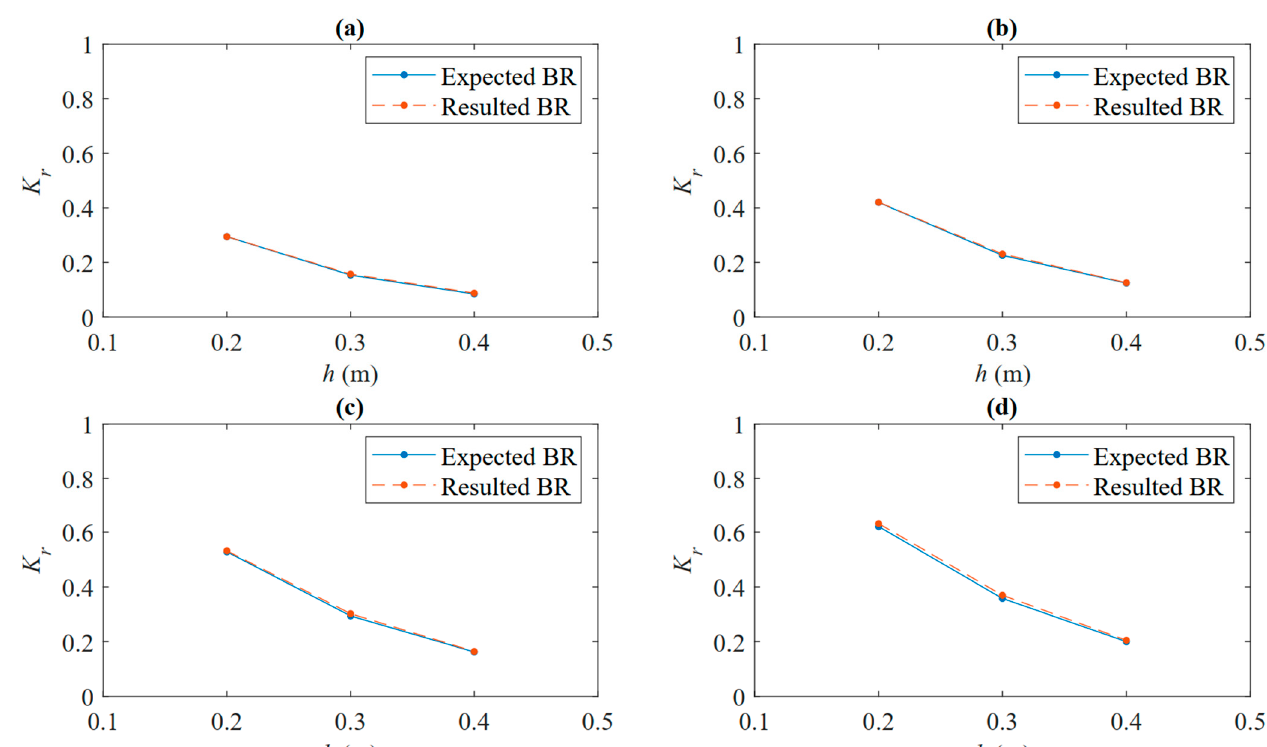
Figure 17. Bragg resonance of multiple periodically submerged breakwaters with 1.0 m structural wavelength S at different water depths. ( a ) 𝑁 = 2 ( b ) 𝑁 = 3 ( c ) 𝑁 = 4 ( d ) 𝑁 = 5 .